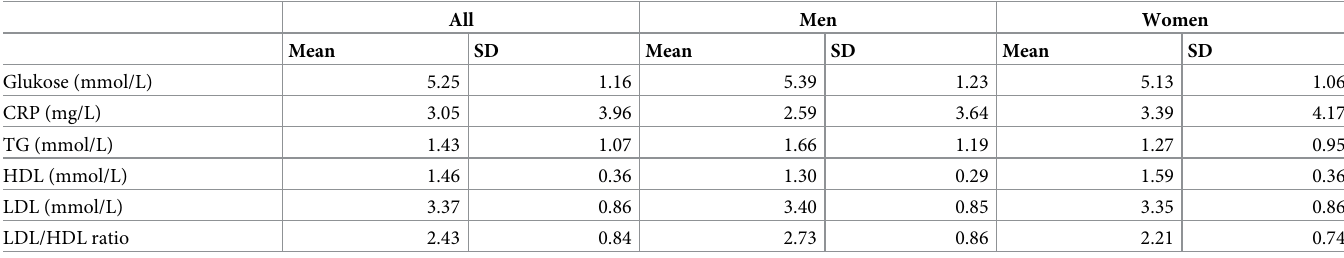
Table 2. Distribution of biomarkers in the analytical sample as a total and by sex.